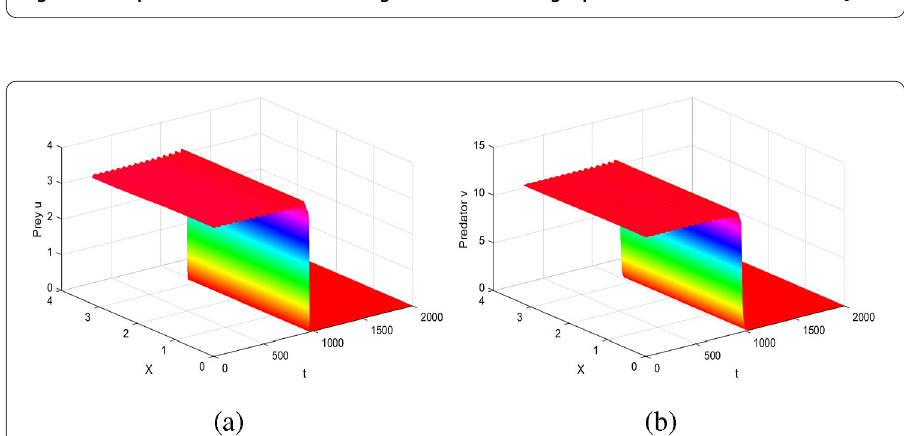
Figure 5 The solution of system (1) converges to E 0 with τ = 4.5 > τ 0 .